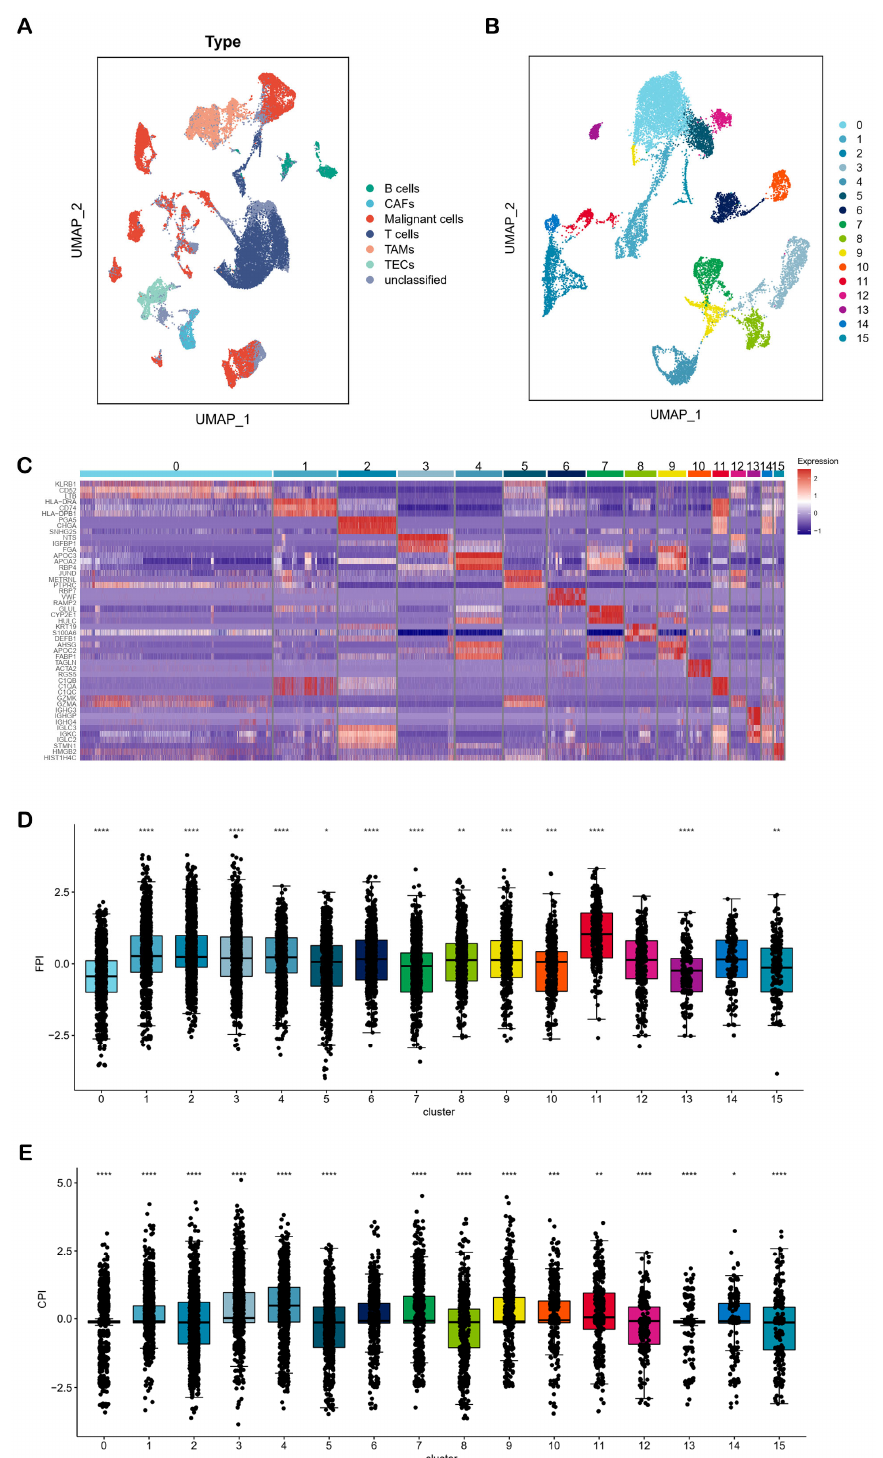
Figure 6. Single cell transcriptome analysis of HCC. ( A ) The UMAP plot of 56,721 single cells from 46 liver tumor samples showed 7 cell types, including B cells, cancer-associated fibroblasts (CAFs), malignant cells, T cells, tumor-associated macrophages (TAMs), tumor-associated endothelial cells (TECs) and unclassified. ( B ) The UMAP plot showed 16 subcluster of malignant cells. ( C ) The heatmap showed the marker genes with significant differences among the 16 subclusters. ( D , E ) FPI and CPI were significantly different among the 16 subclusters. * p < 0.05. ** p < 0.01. *** p < 0.001. **** p <